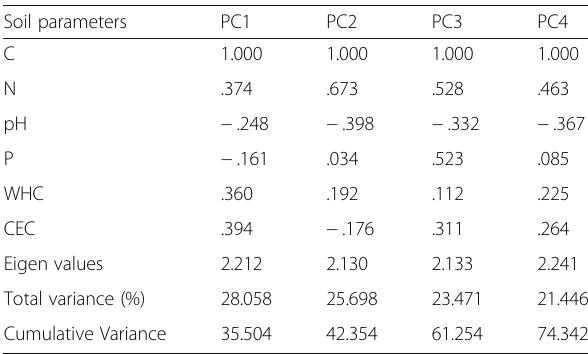
Table 5 Principal components and eigenvalues with total and cumulative variance of soil factors Soil parameters